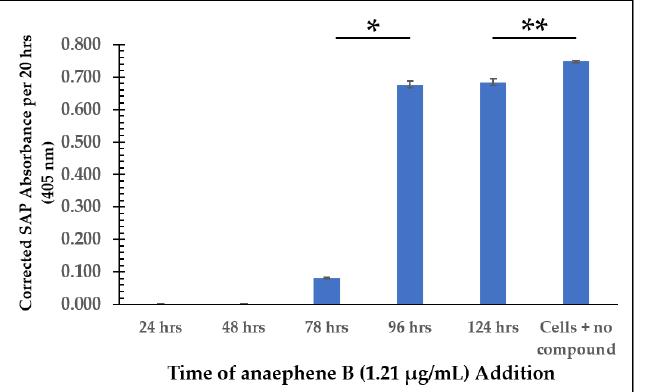
Figure 3. SAP Assay Following Time of Addition Study—Anaephene B Senescence Phase (Cell Culture Age: 528 h). Values are the mean and standard deviation for n = 3 replicates. * denotes p < 0.05 between addition at 78 h vs. 96 h. ** denotes p < 0.05 between addition at 124 h vs. no compound